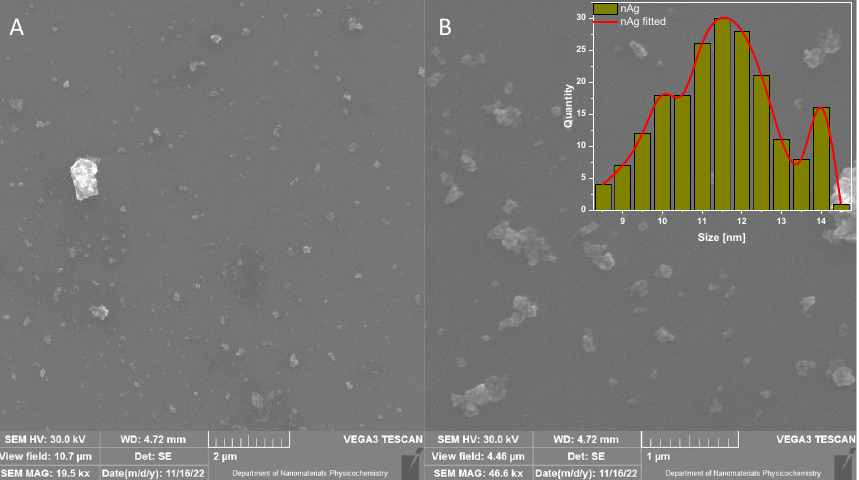
Figure 5. SEM images of silver particles in lower ( A ) and higher ( B ) magnification and ( B ) size